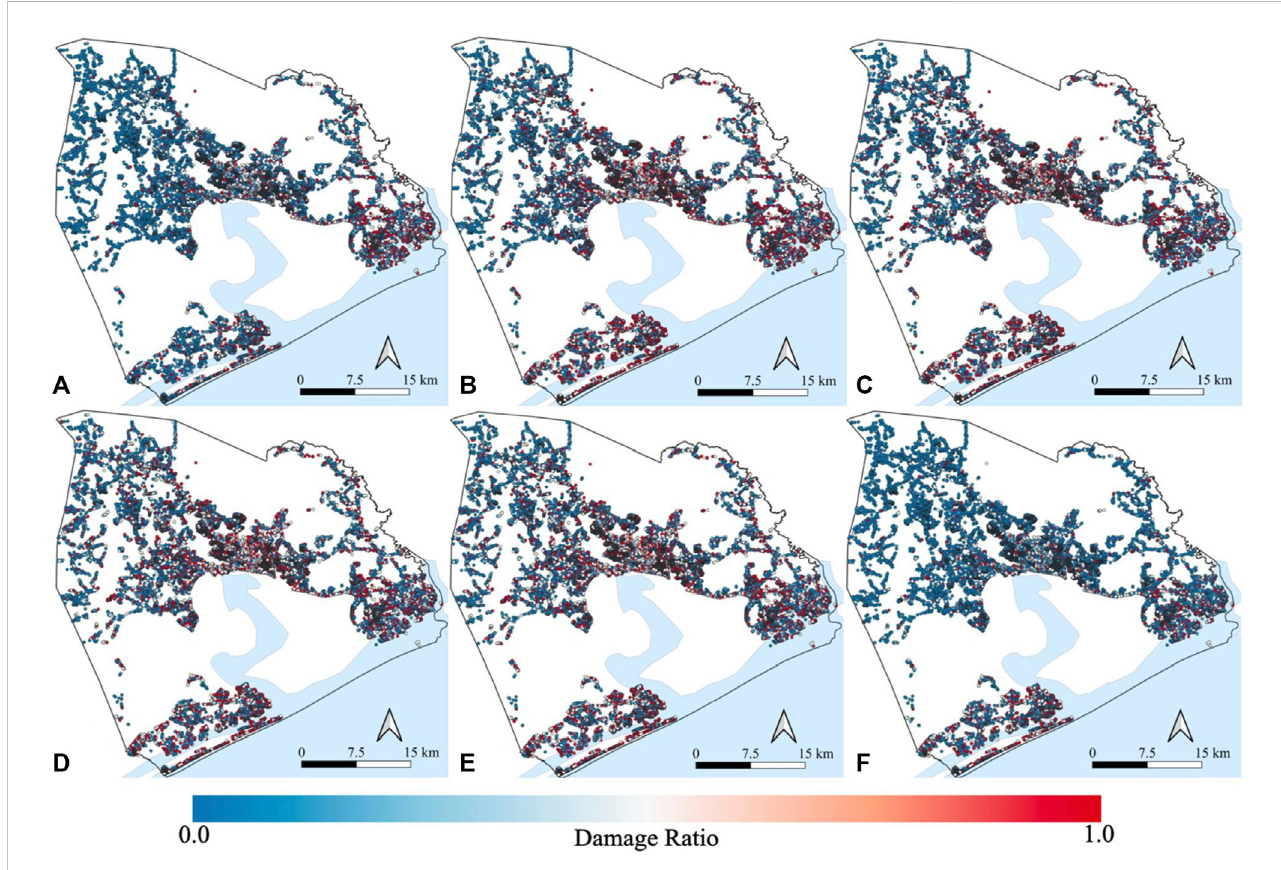
FIGURE 11 Damage ratio maps for hurricanes: (A) P1, (B) P2, (C) P3, (D) P4, (E) P5, and (F) Helene.